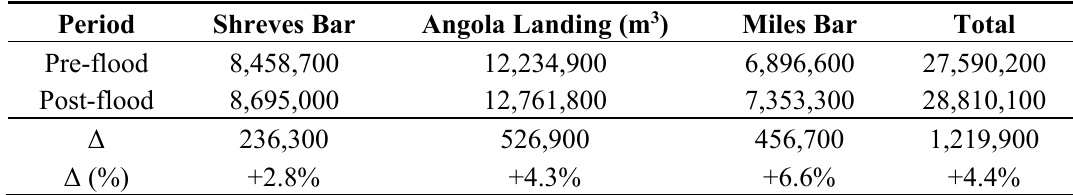
Table 4. Changes ( Δ ) in volume of three large channel bars near Tarbert Landing in the lowermost Mississippi River before and after the 2011 spring